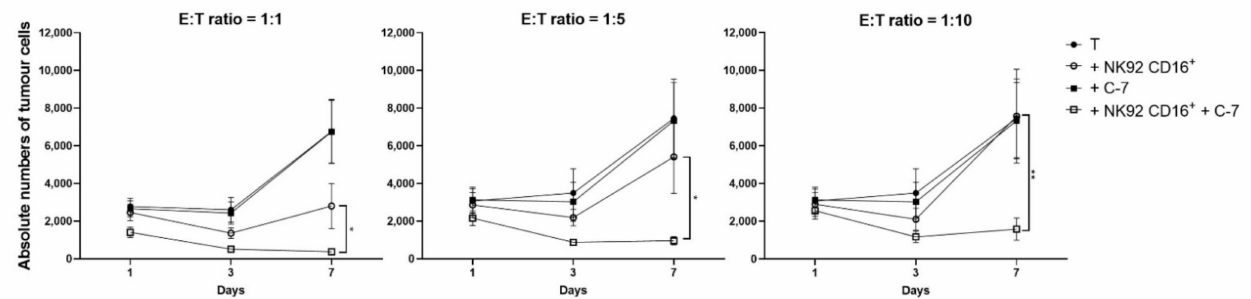
Figure 8. The bispecific C-7 VHH triggers CD16 + NK92 cells to control tumor growth using patient metastatic CRC cells. Dissociated CRC peritoneal metastatic samples ± NK92 CD16 + ± 100 nM C-7 were cultured for 1, 3, and 7 days at multiple E:T ratios, i.e., 1:1 n = 6, 1:5 n = 5, 1:10 n = 5. The significance levels refer to the conditions: “T+NK92 CD16 + ” versus “T+NK92 CD16 + +C-7”. Data are presented as mean ± SEM. Significance is presented as p < 0.05 *, <0.01 **. p -values were determined by two-way ANOVA with Dunnett’s multiple comparison analysis. Abbreviations: T = tumor, C-7 = C21-7D12 bispecific